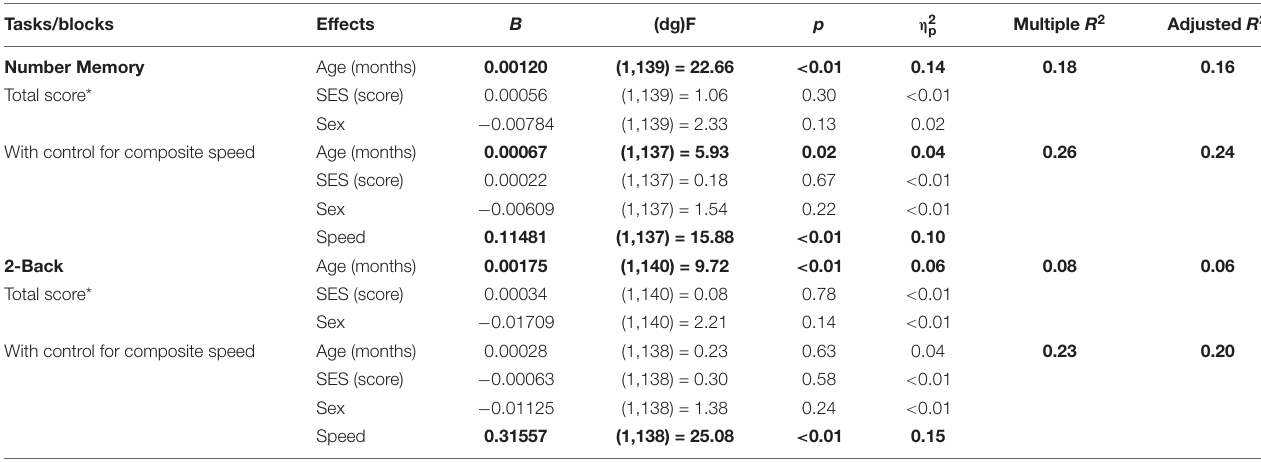
TABLE 5 | Results from the General Linear Models for executive updating tasks/blocks, including age, sex and socioeconomic status (SES) effects.